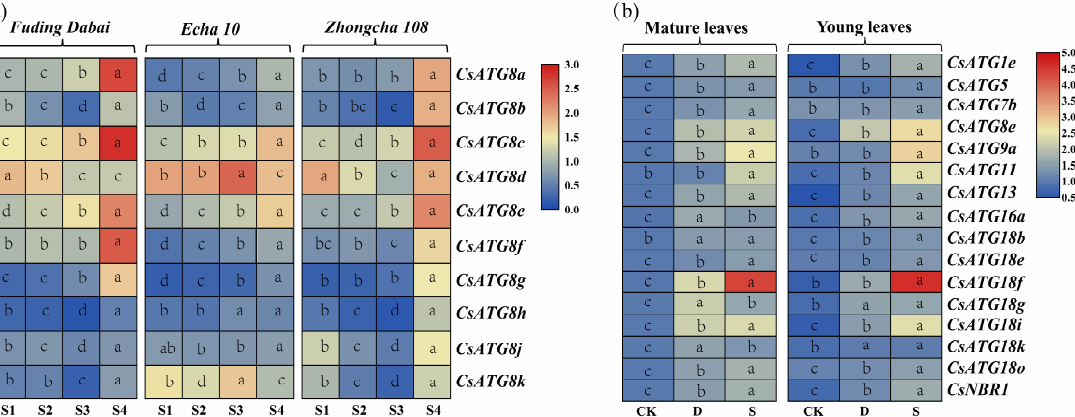
Figure 4. Expression patterns of CsATG genes in Camellia sinensis . ( a ) The expression of CsATG8s in the leaves at four different stages (S1, Stage 1; S2, Stage 2; S3, Stage 3; S4, Stage 4) in tea cultivars of Fuding Dabai , Echa 10 and Zhongcha 108 . ( b ) The expression of sixteen CsATG genes in Zhongcha 108 under different N treatments. Y, young leaves; M, mature leaves; D, N-deficient, 0.125 mM NH 4 NO 3 ; S, N-sufficient, 2.50 mM NH 4 NO 3 ; CK, control. Different lowercase letters in rectangles indicate significant differences at p < 0.05 by analysis of variance (ANOVA) Duncan comparison.